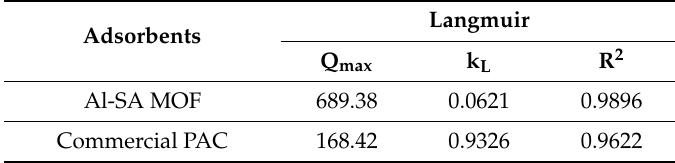
Table 4. Adsorption isotherm parameters for the adsorption of AB1 onto Al-SA MOF and commercial PAC, where Q max = predicted maximum adsorption